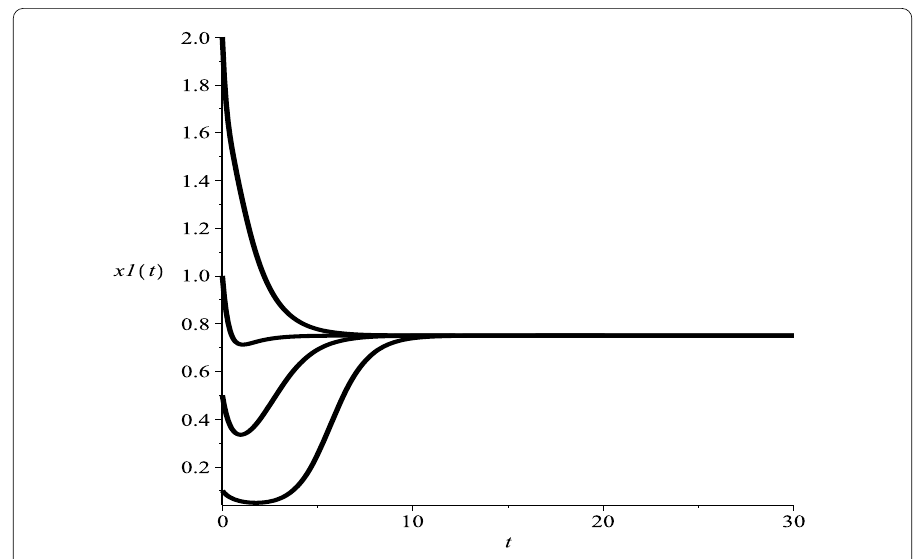
Figure 5 Dynamic behaviors of the first component x 1 ( t ) of system (4.1), here we take d = 2 and the initial conditions ( x